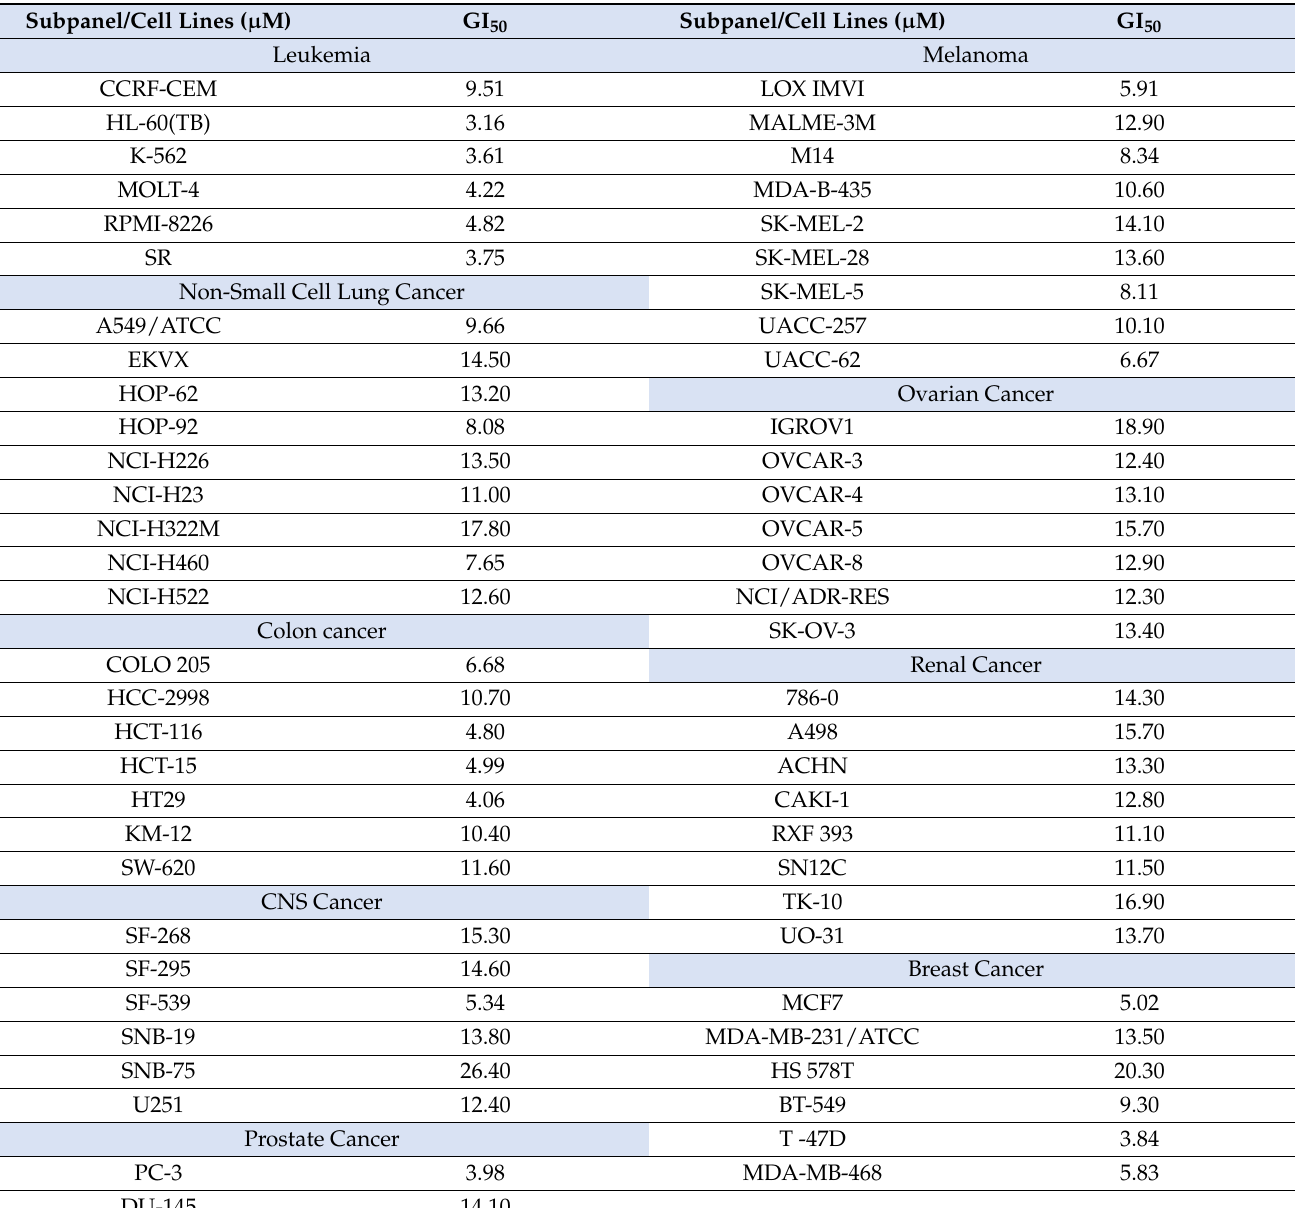
Table 2. In vitro anticancer activity of compound 3 against 60 human cancer cell lines in the second stage in a single concentration of 0.01–100 µ M